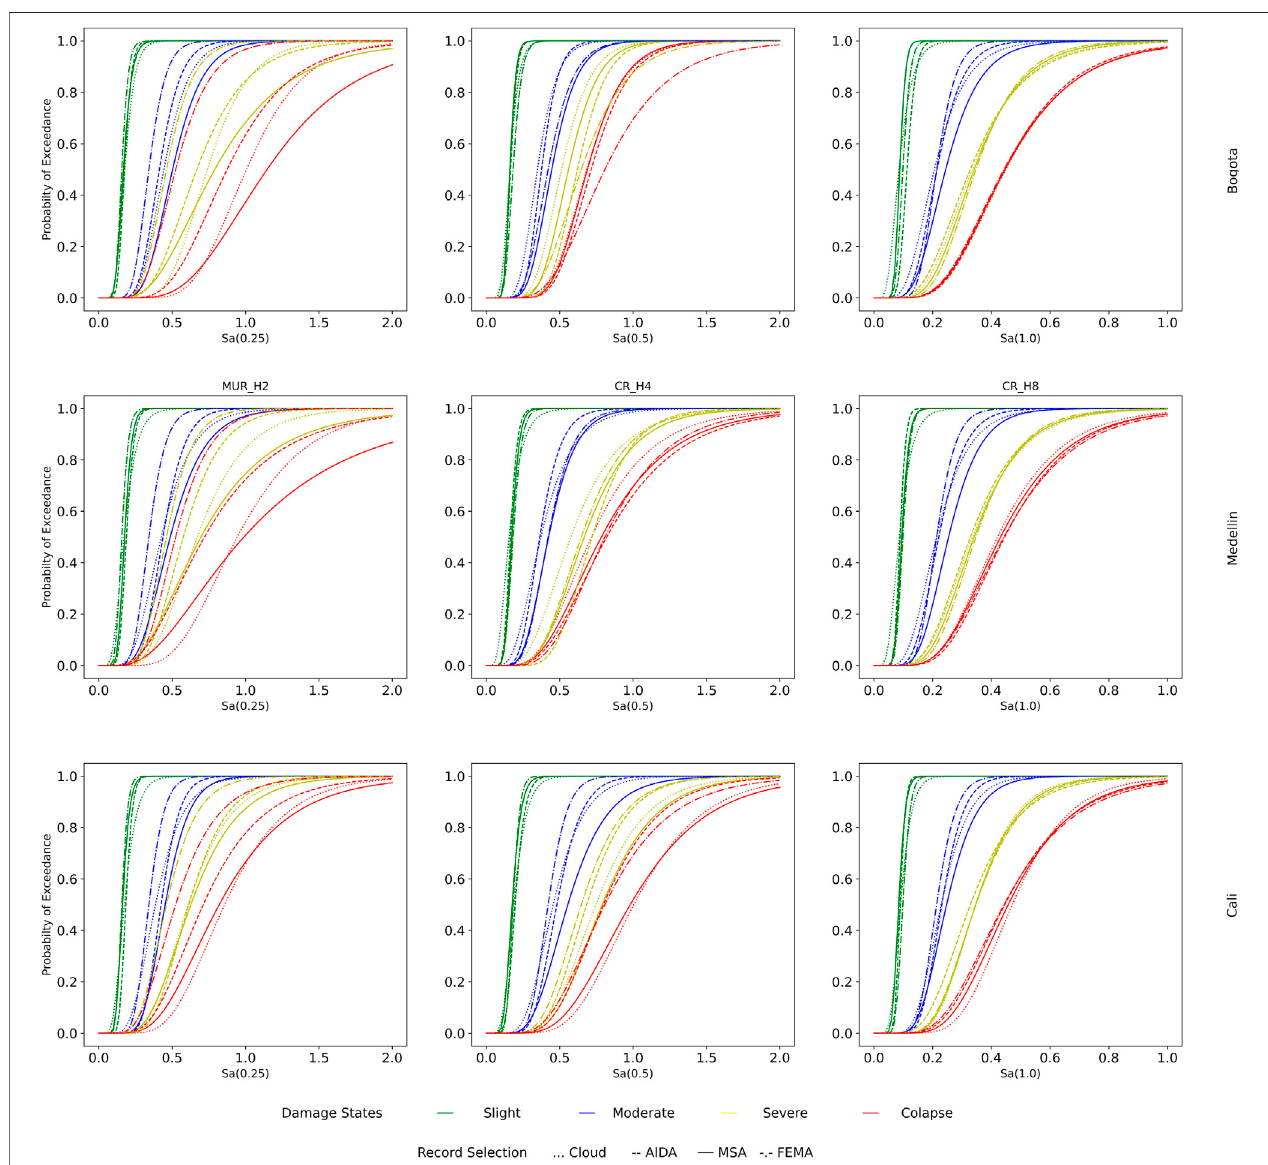
FIGURE9 | Fragility curves derived using different methods: cloud (dotted),AIDA (dashed line), MSA (continuous line), and FEMA (dotted-dashed line); in thethree cities: Bogotá (top), Medellín (center), and Cali (bottom); for the three-building types: two-story unreinforced masonry (left), four-story reinforced concrete (center), and eight-story reinforced concrete